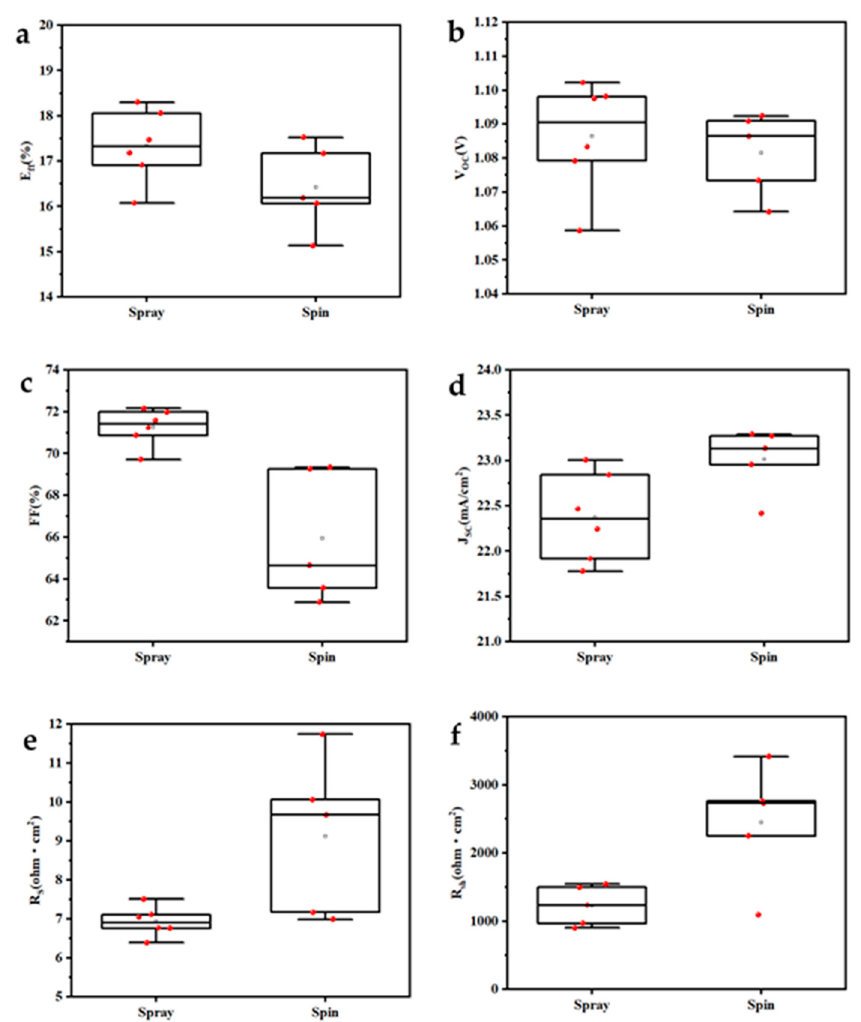
Figure 7. Box plot of light I–V parameters of perovskite cells based on sprayed and spin-coated SnO 2 films. ( a ) E ff , ( b ) V OC , ( c ) FF, ( d ) J SC , ( e ) R S , ( f ) R Sh .